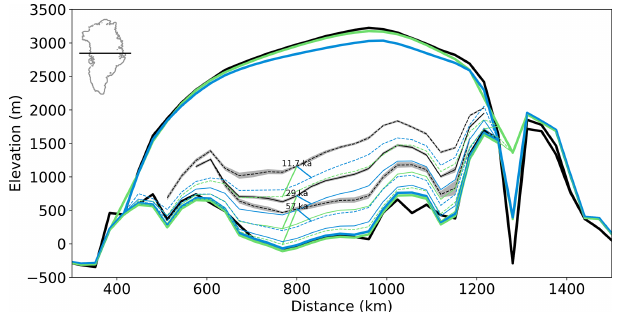
Figure 7. Section through the summit, showing ice surface and bedrock topographies (bold lines), and isochrones (thin lines), each for observations (black), BEST ice (green), and BEST all (blue). Isochrones alternate between solid and dashed line styles to improve visibility. Diagonal lines connect corresponding isochrones for the simulations and observations. Reconstruction data for the 115ka isochrone is not available at this location. Shading is the uncertainty in the observations. Note that distances between isochrones on the elevation scale shown here are not directly comparable to differ- ences in the depth below the surface shown in Figs. 5 and